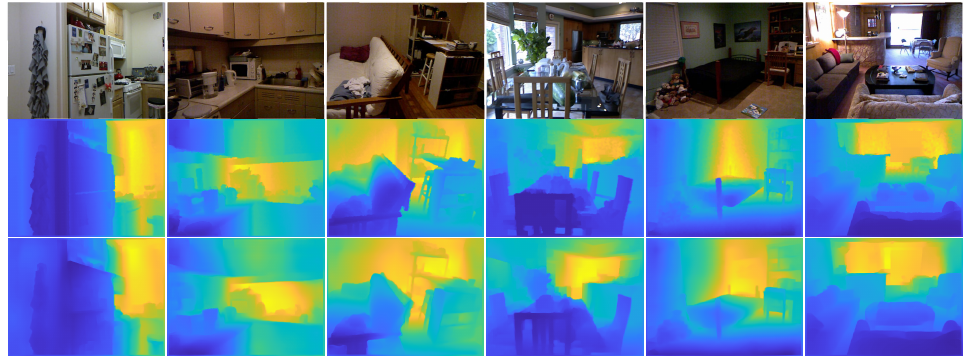
Figure 1. Comparison of estimated depth maps with our model with the NYU Depth-v2 dataset: (Row 1) Input images, (Row 2) ground-truth depth images, and (Row 3) resulting depth